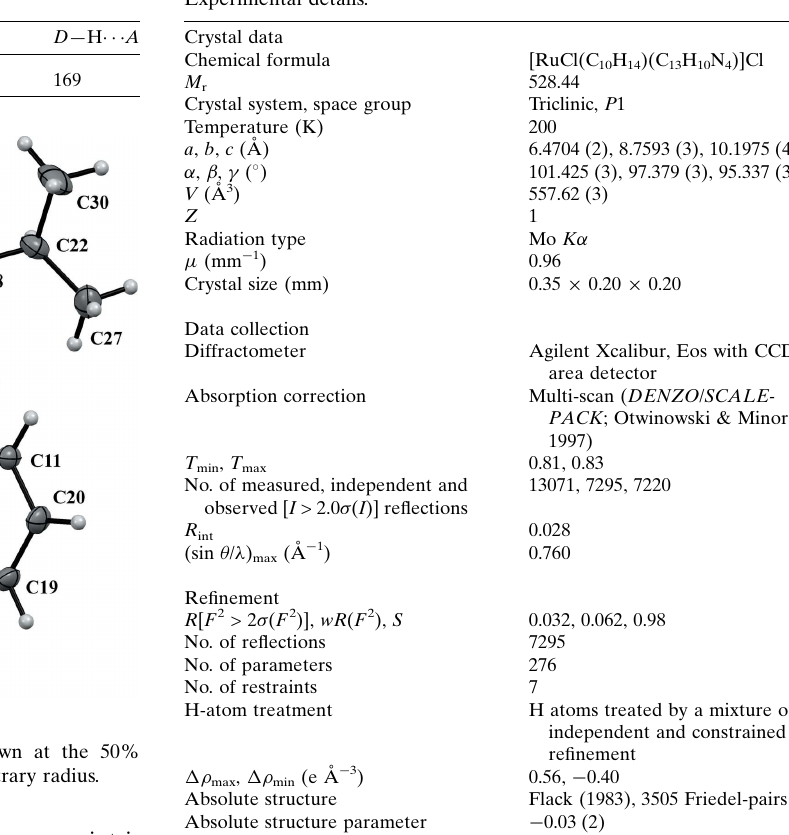
Table 2 Experimental